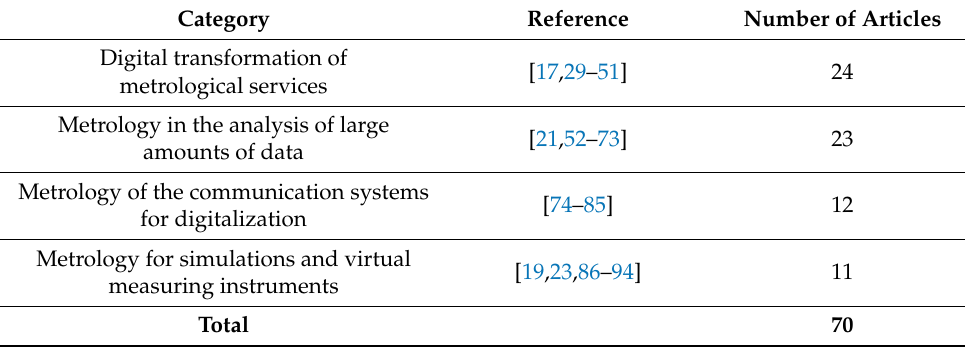
Table 3. Clustering of the selected documents by